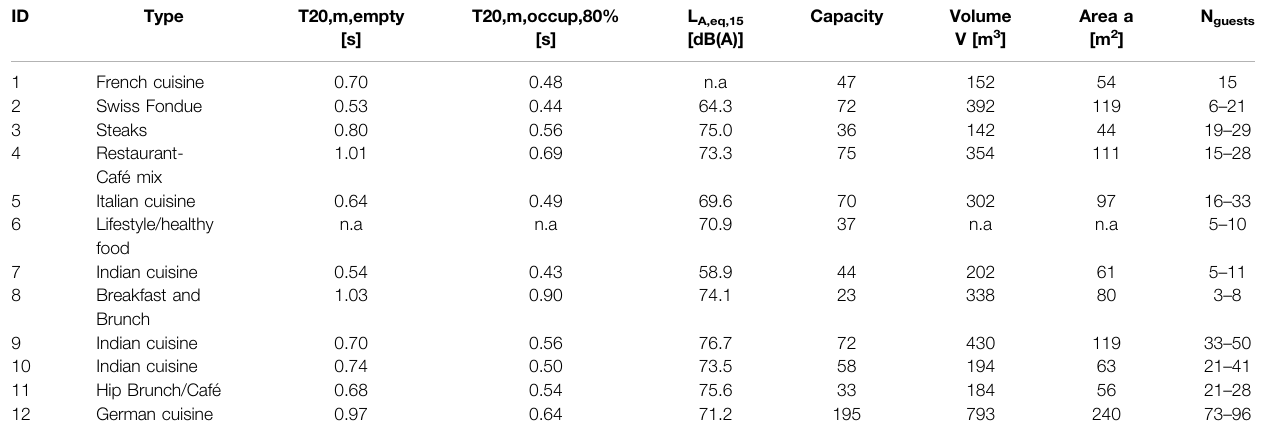
TABLE 1 | Restaurant attributes and requirements according to the DIN 18041-3:2016 and Rindel (2018).